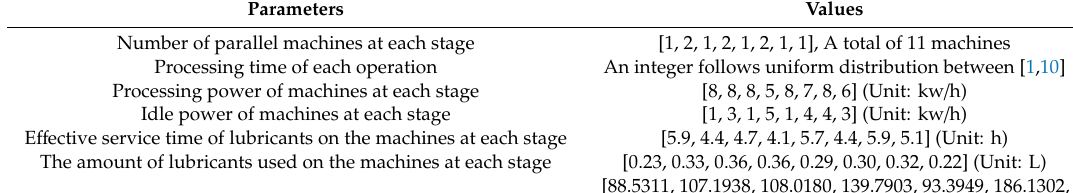
Table 11. Relevant parameters in factory 2.